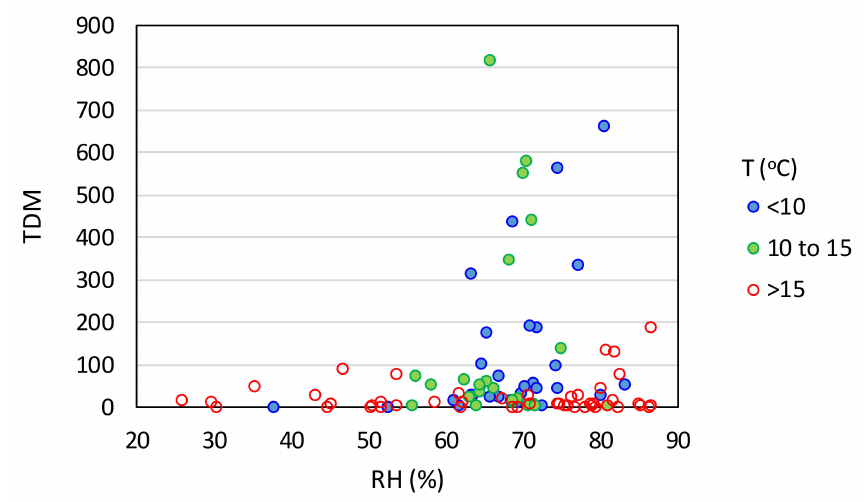
Figure 6. Total deaths per million as a function of the relative humidity and temperature (HDI > 0.7).